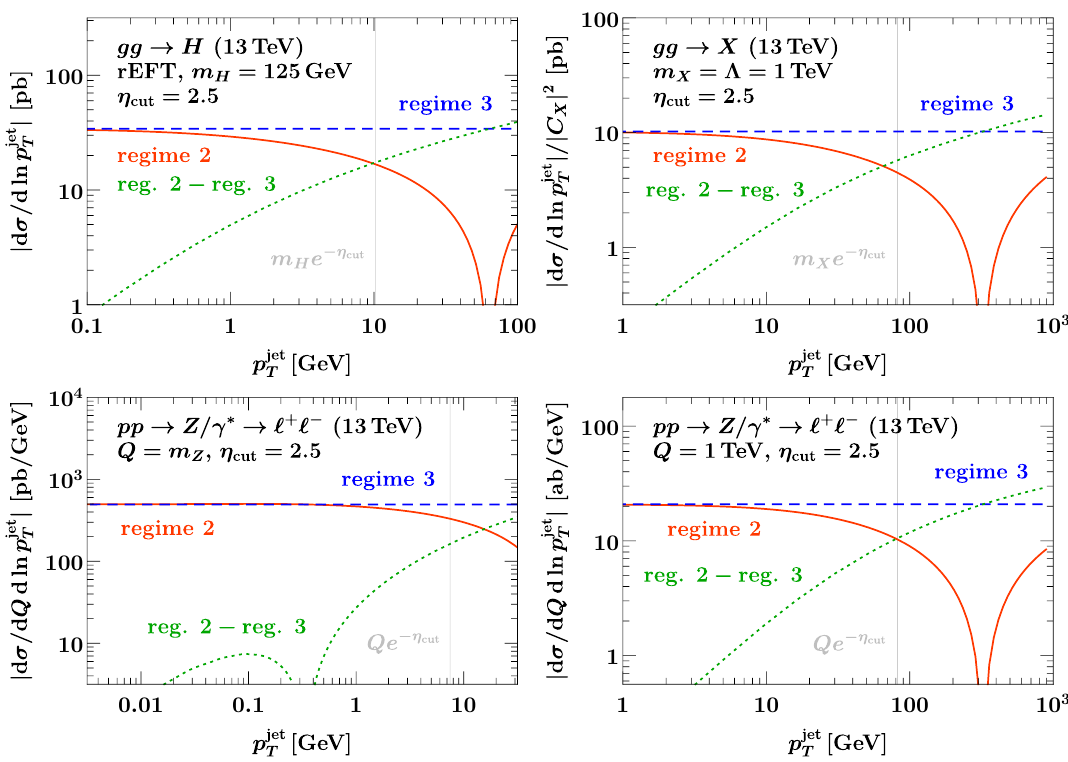
Figure 6 . Comparison of the singular contributions to the (cid:12)xed (top left), gg X (top right), and Drell-Yan at Q = m Z (bottom left) and Q = 1 TeV (bottom ! right). The solid orange lines show the full regime 2 singular spectrum, the blue dashed lines the further factorized regime 3 result. Their di(cid:11)erence shown by the dotted green lines vanishes as a power in p jet =Qe (cid:0) (cid:17) cut for small p jet . The vertical lines indicate where the relation p jet T T is